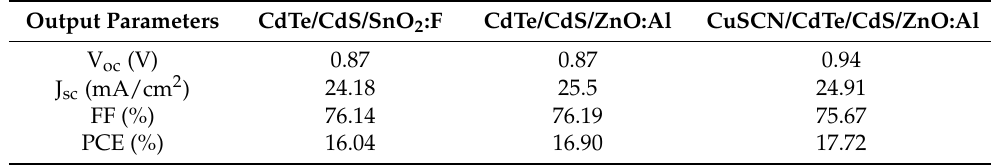
Table 5. J-V curves of different CdTe solar cell